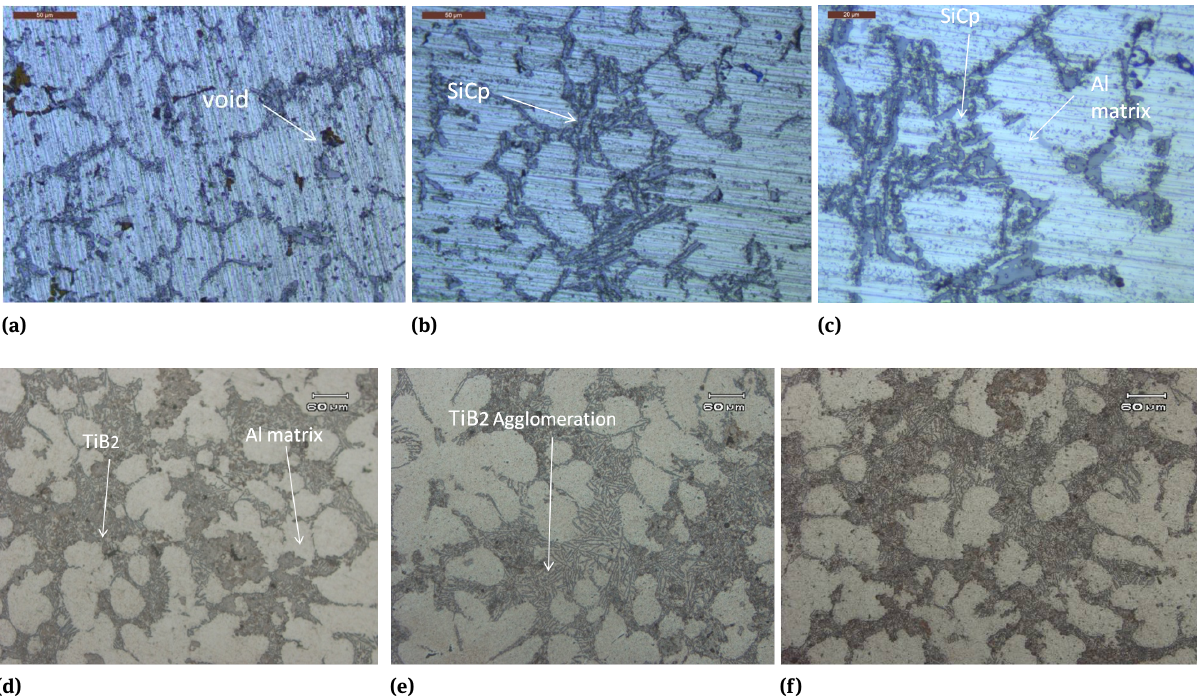
Figure 2: (a) Optical micrographs of Al/SiCp prepared 730 ∘ C; (b) Optical micrographs of Al/SiCp prepared 750 ∘ C; (c) Optical micrographs of Al/SiCp prepared 770 ∘ C; (d) Optical micrographs of Al/ TiB2 prepared 780 ∘ C; (e) Optical micrographs of Al/TiB2 prepared 820 ∘ C; (f) Optical micrographs of Al/TiB2 prepared 840 ∘ C